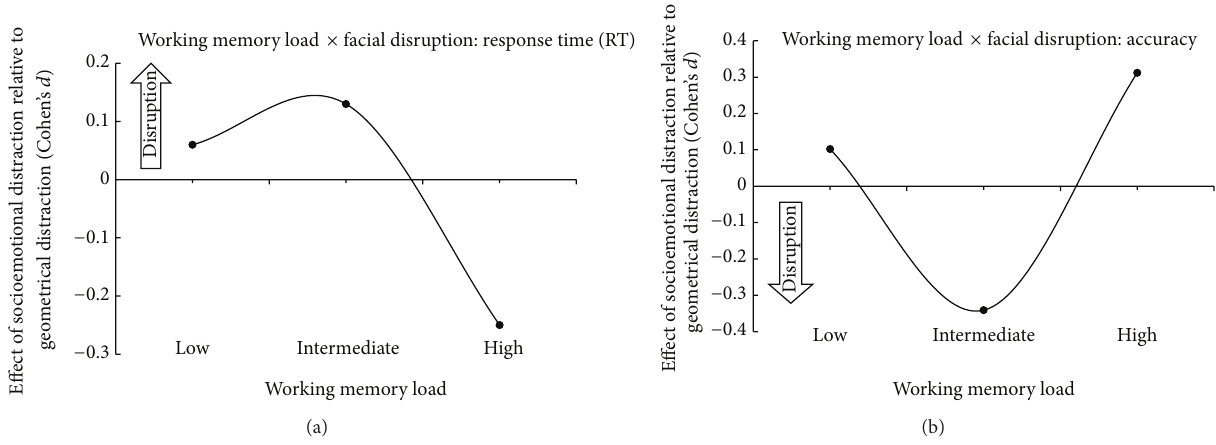
Figure 2: Modulation effects of all facial distracters are displayed relative to nonfacial geometric distracters. The zero axis value represents working memory performance in the context of nonfacial geometrical distracters. In (a) depicting response latencies relative to nonfacial geometrical distracters, positive effect sizes connote behavioral disruption while negative effect sizes connote behavioral facilitation. In (b) depicting accuracy relative to nonfacial geometrical distracters, positive effect sizes connote behavioral facilitation while negative effect sizes connote behavioral